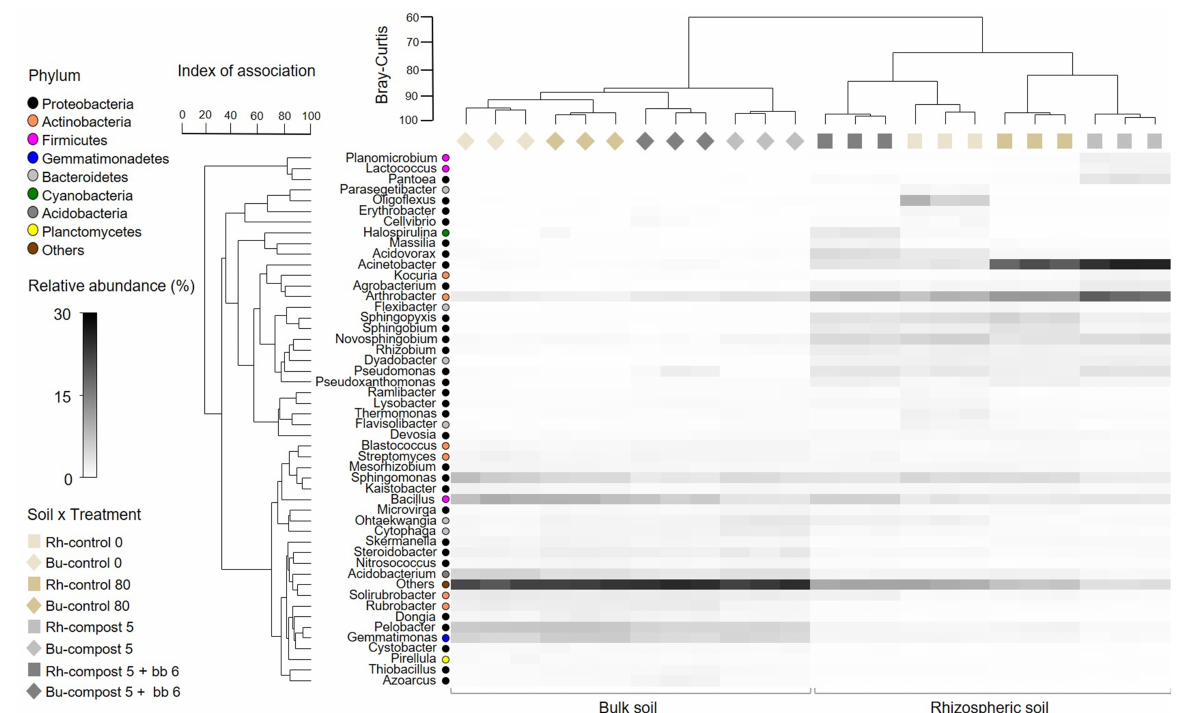
Figure 7. Heat plot showing the relative abundance of the 50 most frequent taxa in the bacterial community. In the column legend, the same color and shape indicate replicates of the same treatment and the same type of soil (Rh, rhizospheric; Bu, Bulk).